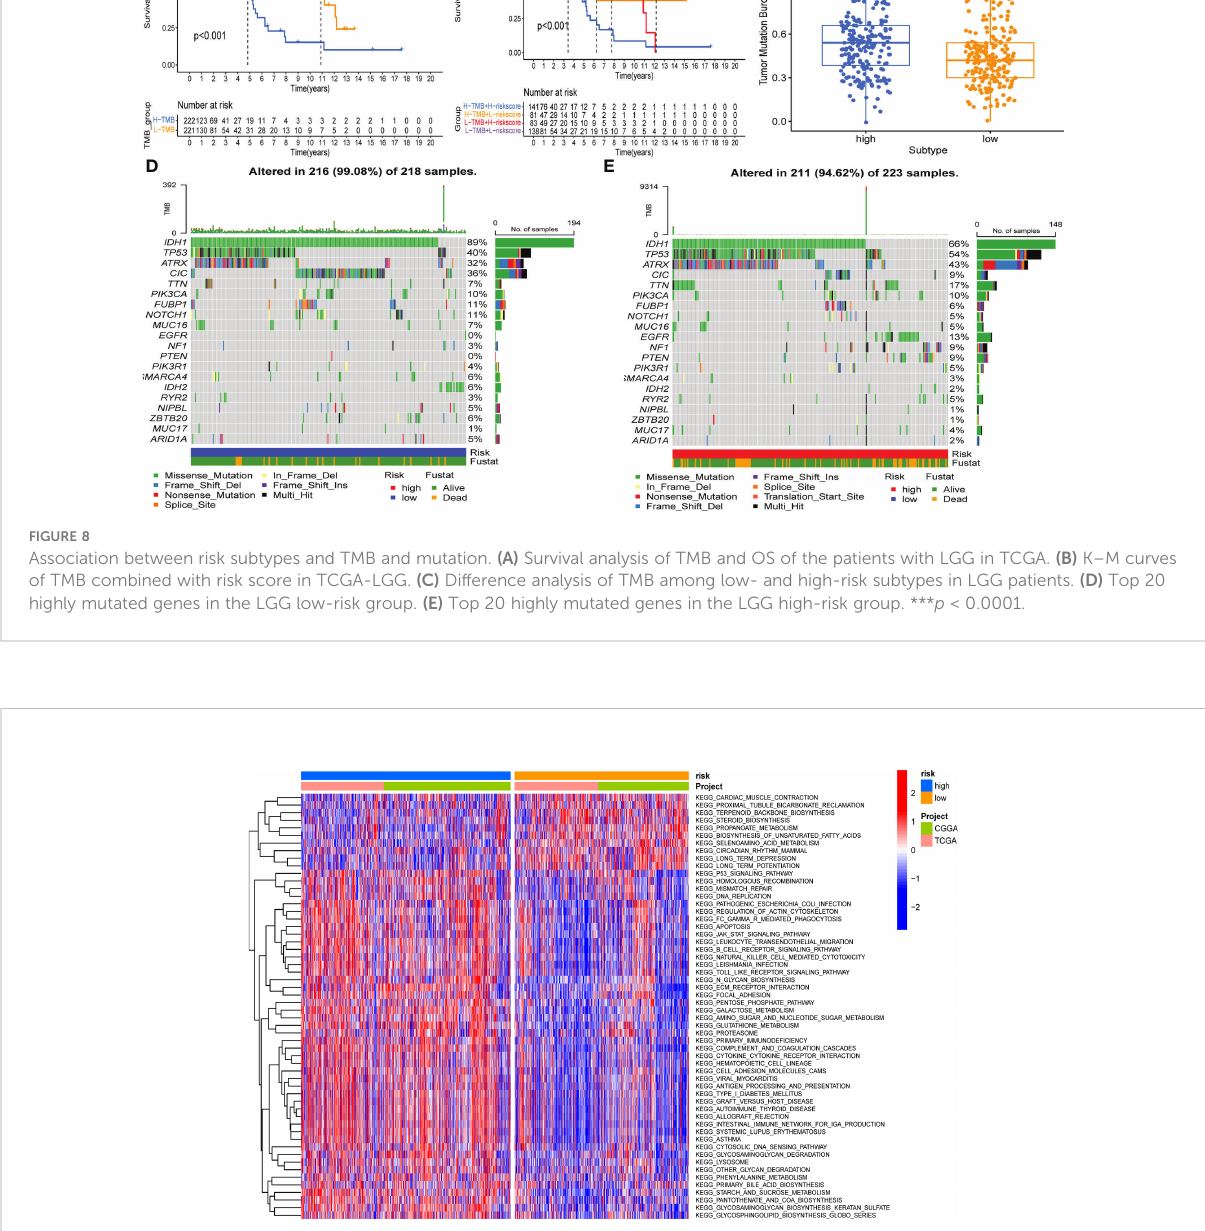
FIGURE 9 Heatmap for the contribution of gene set variation analysis (GSVA) scores of KEGG in low- and high-risk